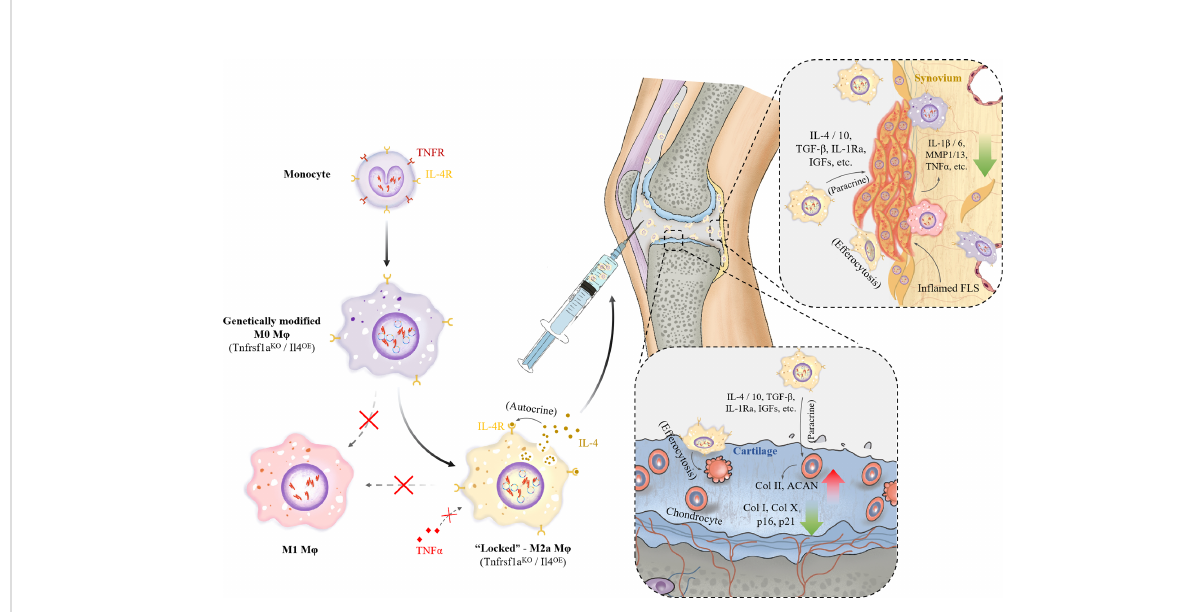
FIGURE 7 Diagram of construction of L-M2a M j s and mechanism of its function in